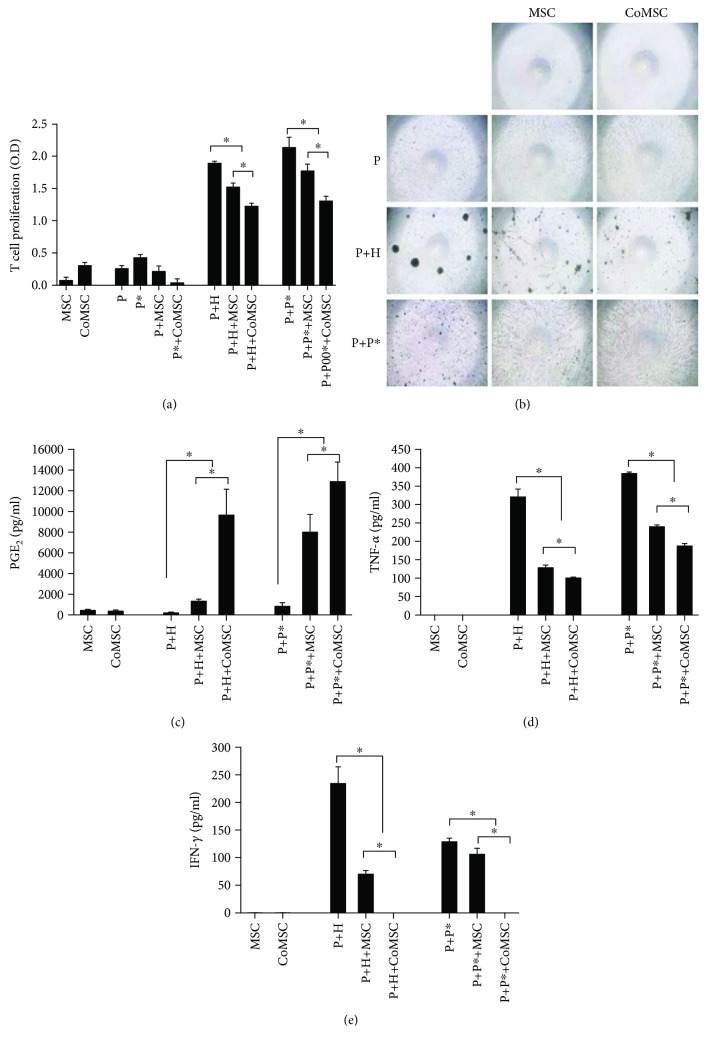
Cobalt chloride (CoCl2) stimulates the immunomodulation of human umbilical cord blood-derived mesenchymal stem cells (hUCB-MSCs). (a and b) The immunogenicity of hUCB-MSCs was assessed using the MLR assay. Allogeneic hPBMCs were cocultured with hUCB-MSCs. The proliferation of responding cells was assessed using the MLR assay. PGE2 (c), TNF-α (d), and IFN-γ (e) levels in the MLR culture supernatants were measured by ELISA. Data represent the mean ± SD, n = 3; ∗
p < 0.05. P: hPBMCs; P∗: allogeneic hPBMCs as stimulator; H: phytohemagglutinin; MSC: naïve hUCB-MSCs; CoMSC: CoCl2-pretreated hUCB-MSCs.